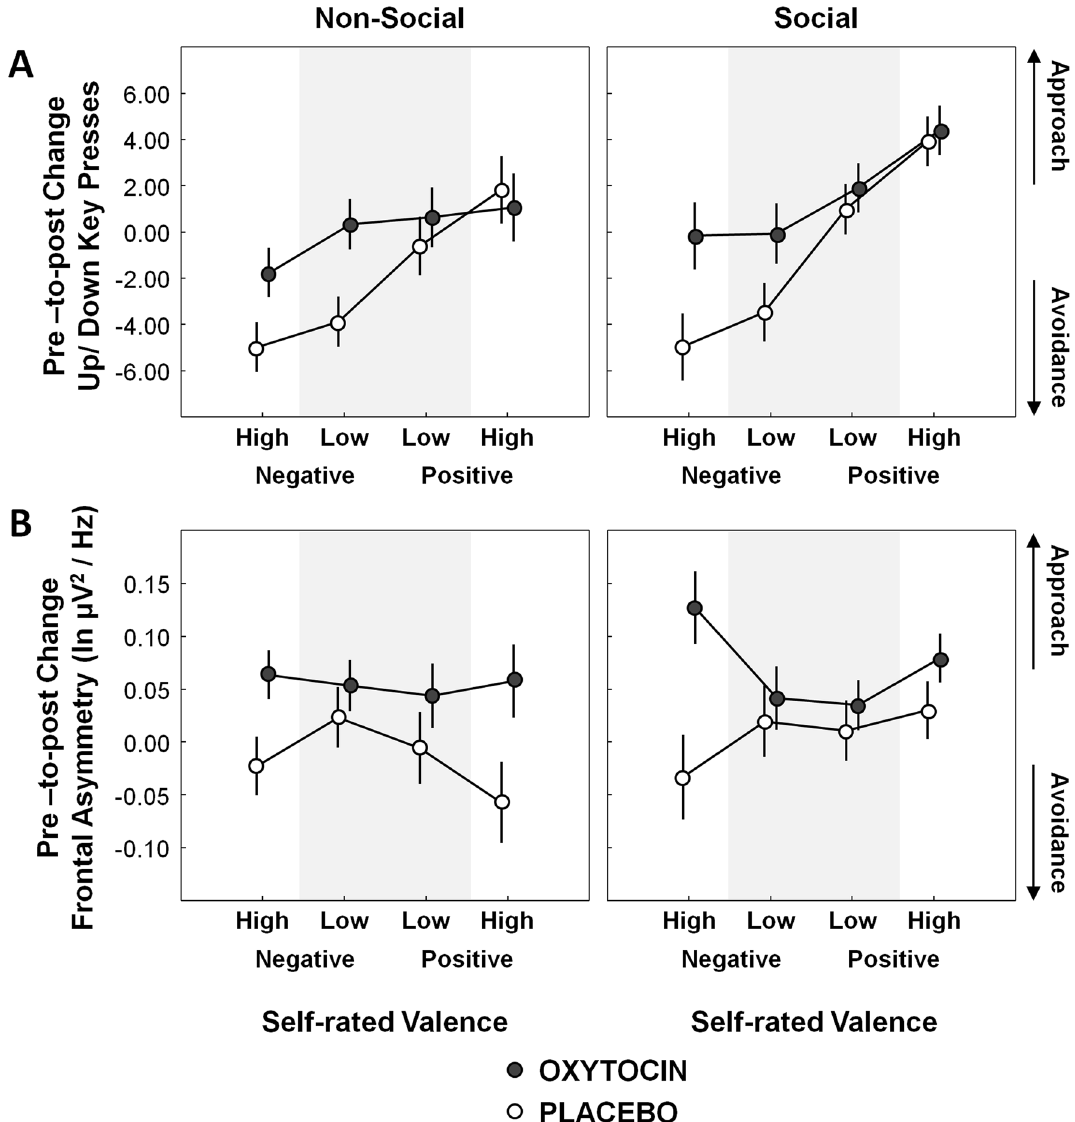
Figure 2. Effect of oxytocin on approach/avoidance as a function of self-rated stimulus characteristics. ( A ) visualizes pre-to-post changes in behavioral approach-avoidance (key press task, KPT) with positive scores indexing increased approach (prolongation of viewing time by pressing the ‘up’ key) and negative scores indexing increased avoidance (shortening of viewing time by pressing the ‘down’ key). ( B ) visualizes pre-to-post changes in EEG frontal alpha asymmetry scores, with positive scores indicating an increase in approach-related left-sided frontal alpha asymmetry. Pre-to-post change scores are visualized separately for each treatment group (oxytocin, placebo), as a function of self-rated sociality (social, non-social), affective valence (negative, positive) and valence intensity (high, low evocativeness). Vertical bars denote ± standard